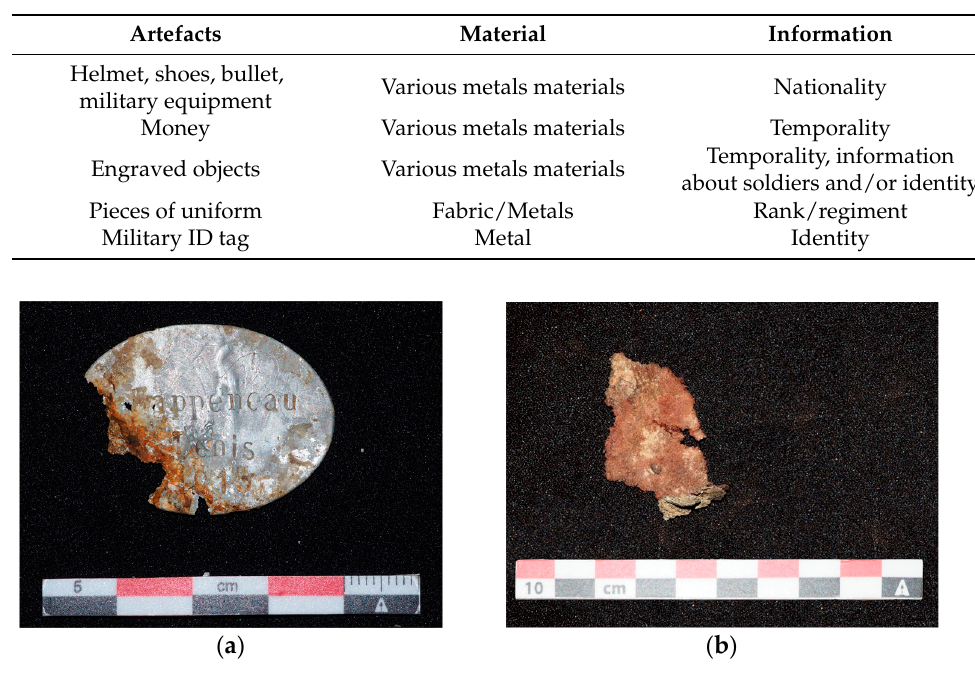
Figure 2. Military documents with mentions of particular conditions: ( a ) “3rd phalanx of the left hand amputated”; ( b ) “Broken right hand little finger”; ( c ) “Medium deviated spine”. © Departmental archives from Seine-et-Marne.